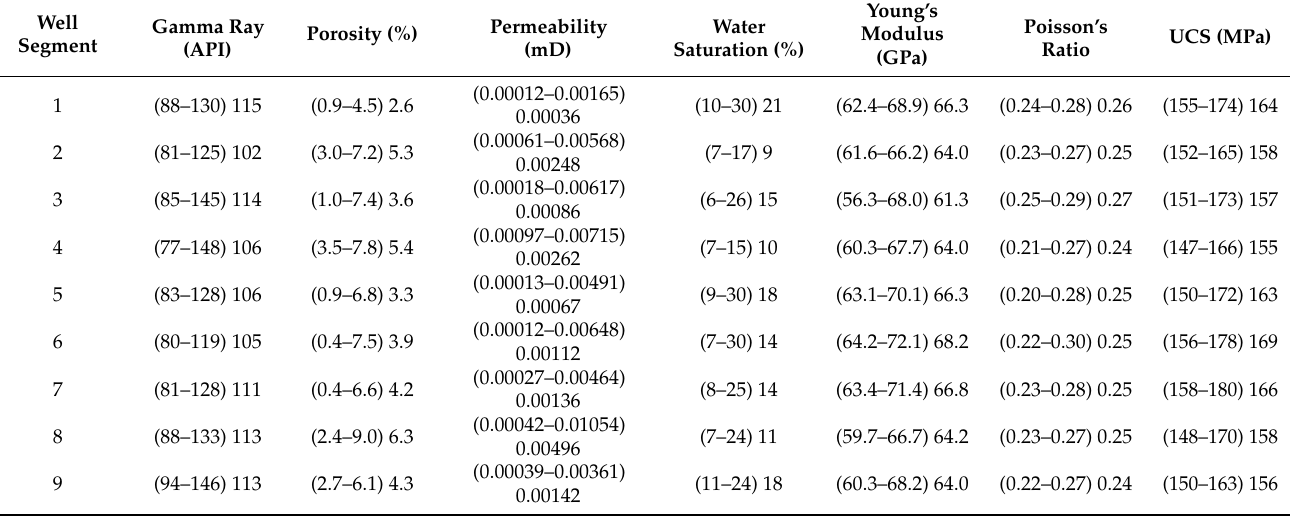
Table 2. Summary of the log-calculated petrophysical and geomechanical properties for the nine segments identified along the well. The numbers in brackets are the range (min-max), and the number below the bracket is the average value for the